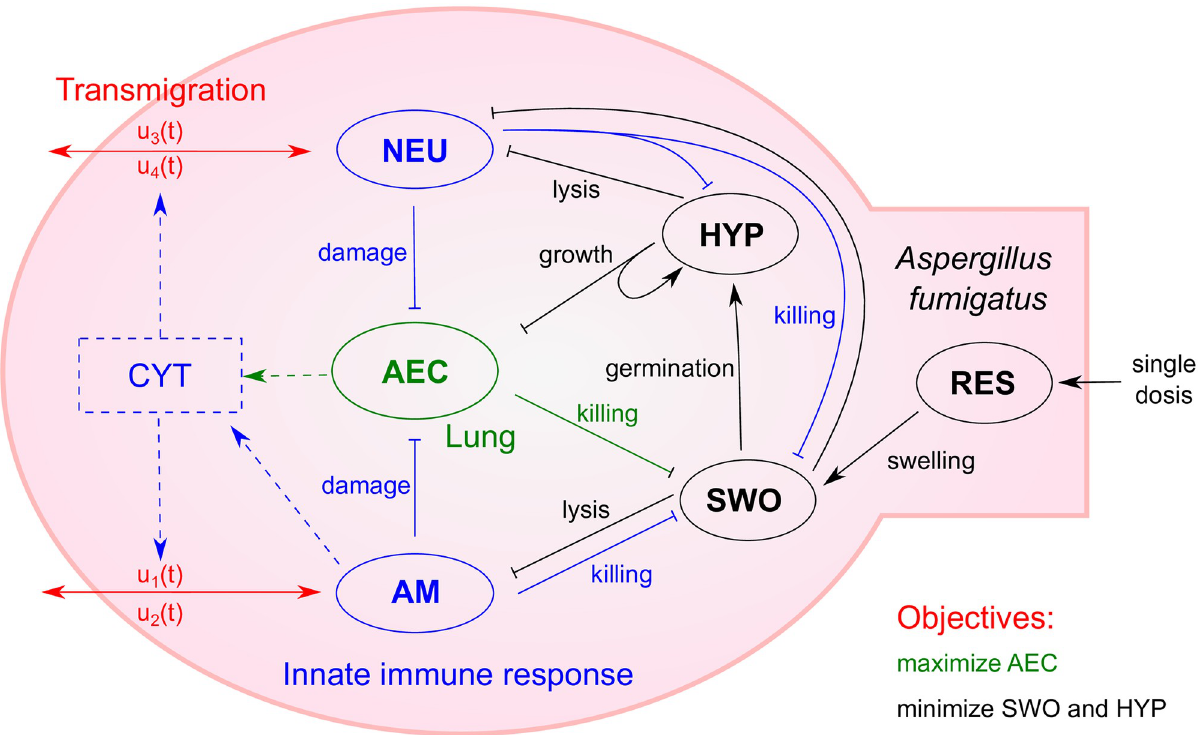
Fig 1. Model of invasive aspergillosis and the innate immune response as dynamic optimization problem. The different fungal growth states (black) including resting conidia (RES), swollen conidia (SWO) and hyphae (HYP) interact with alveolar epithelial cells (AEC, green) as well as with neutrophils (NEU, blue) or alveolar macrophages (AM, blue). Immune cell population is optimized via transmigration (red), which is linked to the cytokine level (CYT, blue), and optimal recruitment and depletion attain the trade-off between pathogen minimization and tissue integrity. Arrow heads indicate a positive interaction and bars show negative